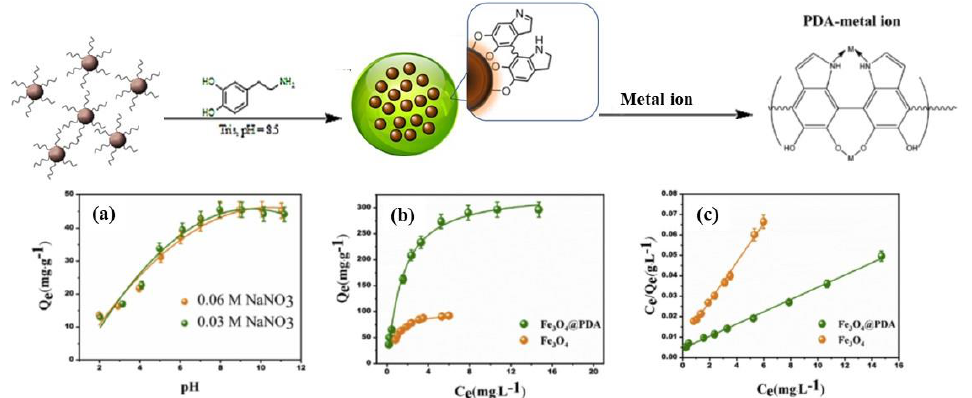
Figure 3. The structure of Fe 3 O 4 /PDA and its interaction with metal ions. Influence on adsorption of ( a ) pH and ionic strength; ( b ) concentration; ( c ) Langmuir model for Cd(II) adsorption, where Q e (mg/g) is the equilibrium adsorption capacity and C e is the Cd(II) concentration at the equilibrium conditions. Reproduced with permission from ref. [74]. Copyright 2019